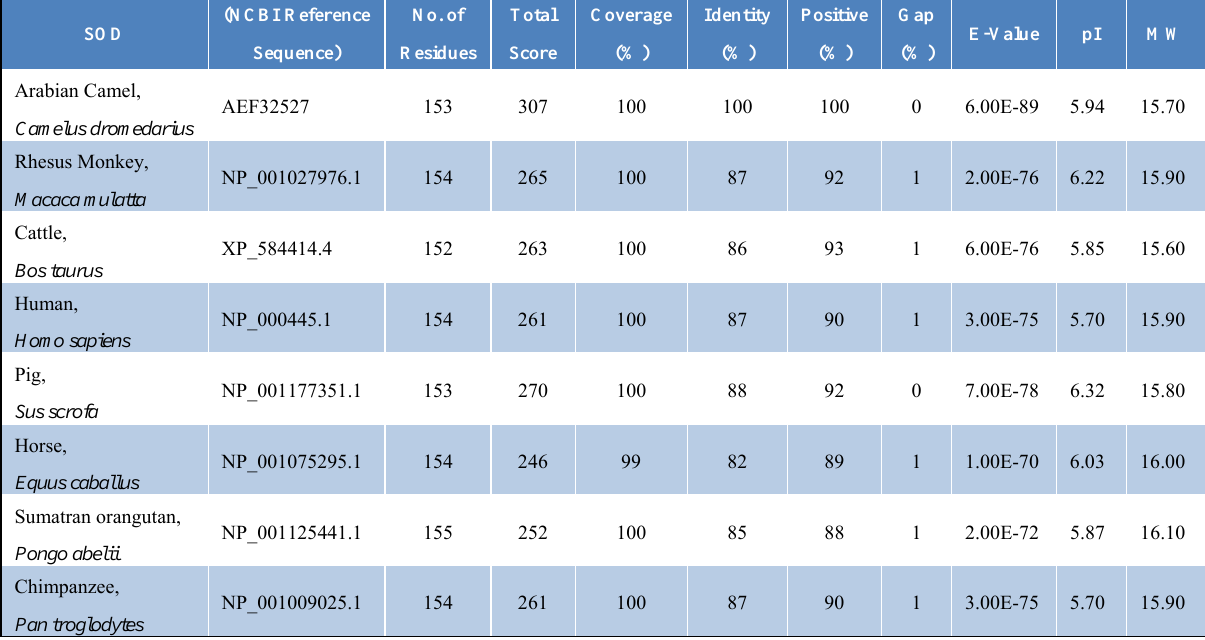
Table 2. Comparison of cSOD1 and other SOD1 enzymes from different mostly similar organisms. The comparison included number of amino acid sequence, percent identity, E-value, isoelectric point (pI) and subunit molecular